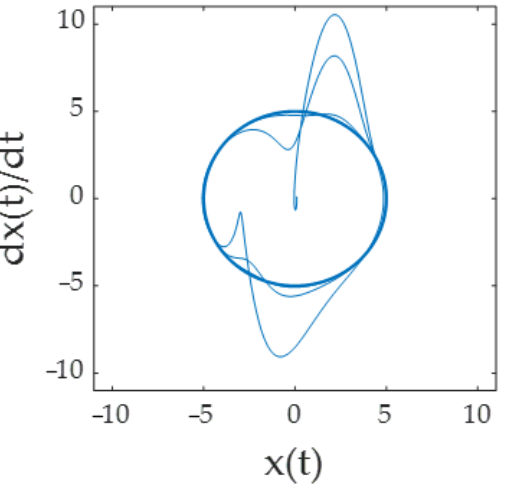
Figure 3. The van der Pol response oscillator is forced to follow a prescribed circular trajectory. Error between the response oscillator trajectory and the target trajectory asymptotically approaches